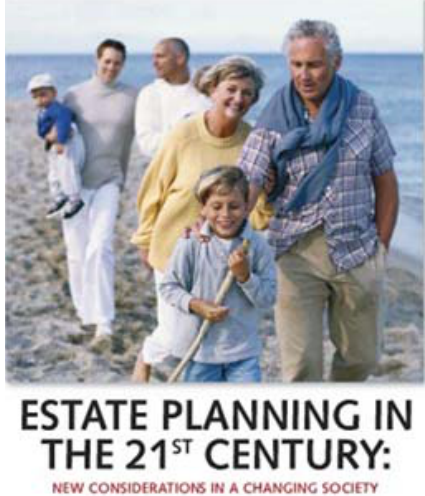
Zoomer Magazine 07/2012, p. 3.